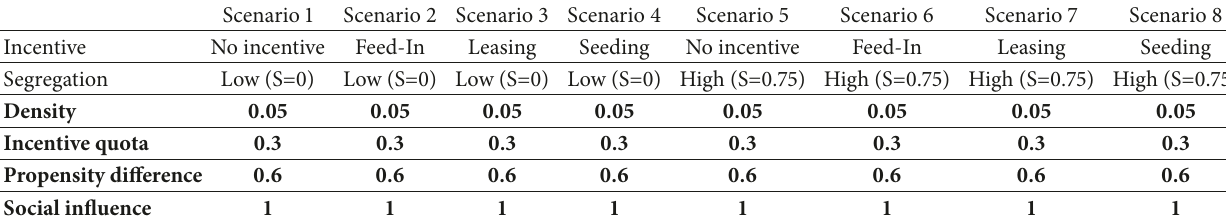
Table 1: Model scenarios: overview over determining